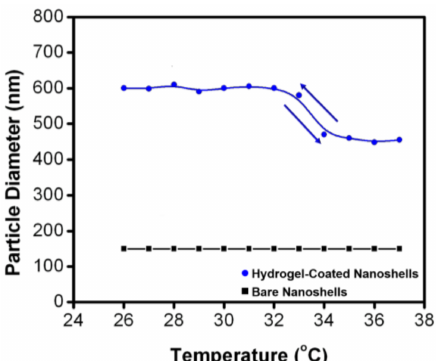
Figure 4. The hydrodynamic diameter of bare nanoshells (black square) and hydrogel-coated nanoshells (blue circle) as a function of temperature. The data shown correspond to a representative set taken from three separate experiments.